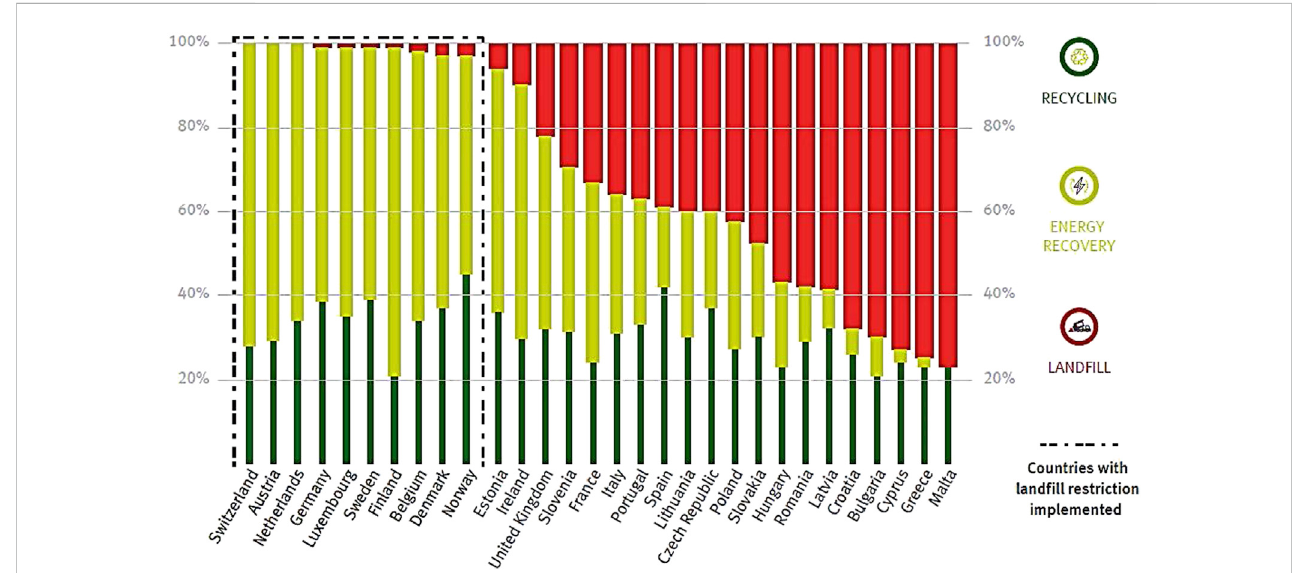
FIGURE 2 Recycling, energy recovery, and land fi ll percentages for plastic post-consumer waste in the EU in 2018 (Plastic-Europe, 2019).